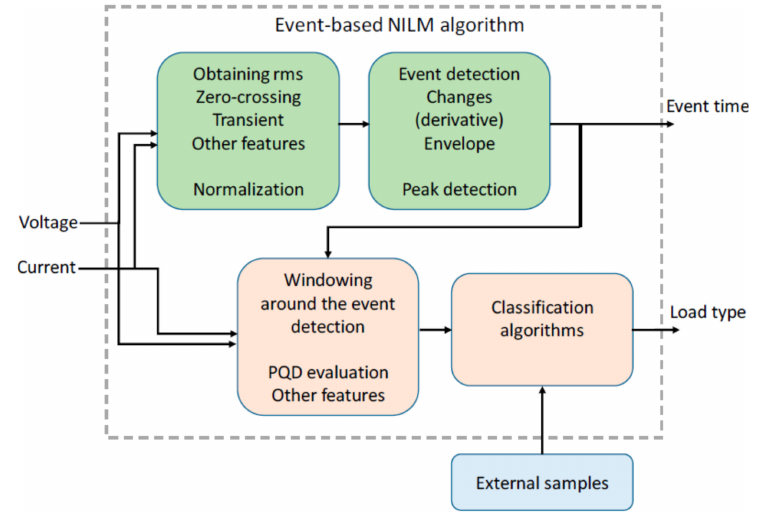
Figure 5. States of a washing machine with di ff erent washing programs. (Reproduced with the permission from [5], 2016).